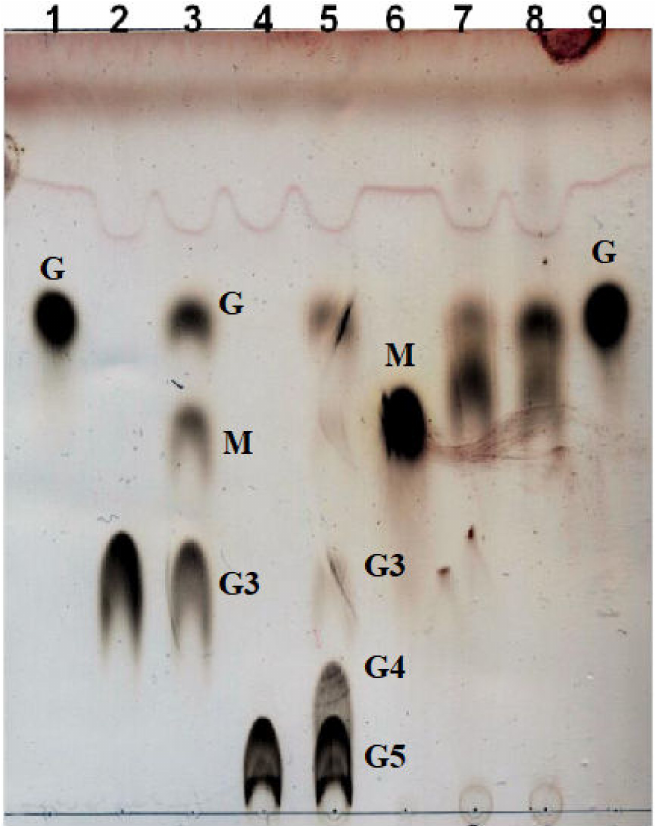
Figure 5. TLC analysis of the enzymatic assays on maltotriose, maltopentaose and nigerose. Lanes 1 and 9: Glucose. Lane 2: blank on maltotriose. Lane 3: Aglu1 on maltotriose. Lane 4: blank on